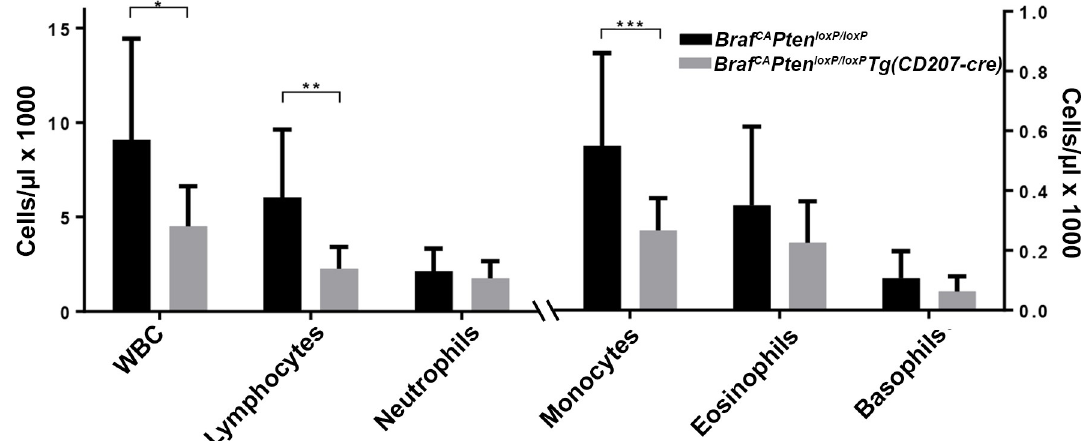
Fig 10. Peripheral blood counts in Braf CA Pten loxP/loxP Tg(CD207-cre) mice. Total white blood count (WBC) and differential count in Braf CA and Braf CA Pten loxP/loxP Tg(CD207-cre) mice. WBC, lymphocyte, and neutrophil counts are shown on the left ordinate; monocyte, eosinophil, and basophil counts are shown on the right ordinate. Results are shown as the mean and standard deviation of 8 Braf CA and 8 Braf CA Pten loxP/loxP Tg(CD207-cre) mice, aged 19 to 31 days. Comparisons made by two-sided Welch t-test: � , p = 0.0512; �� , p = 0.0213; ��� , p = 0.0487.